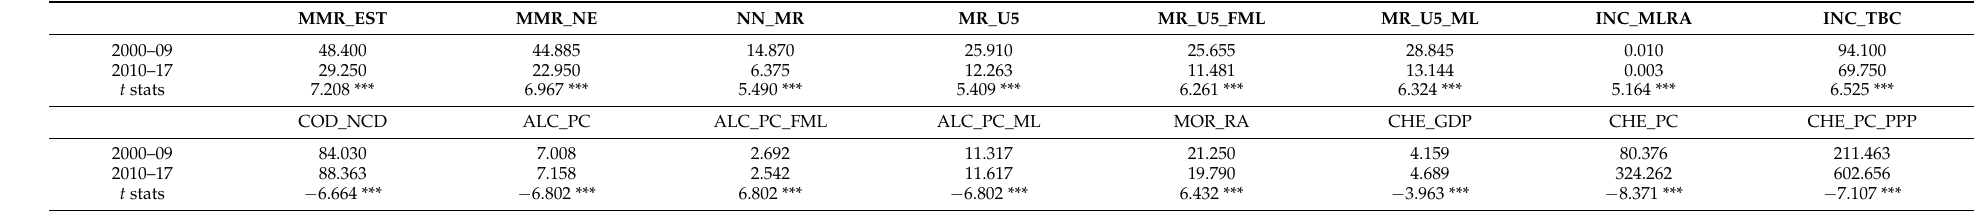
Table 4. Difference in mean